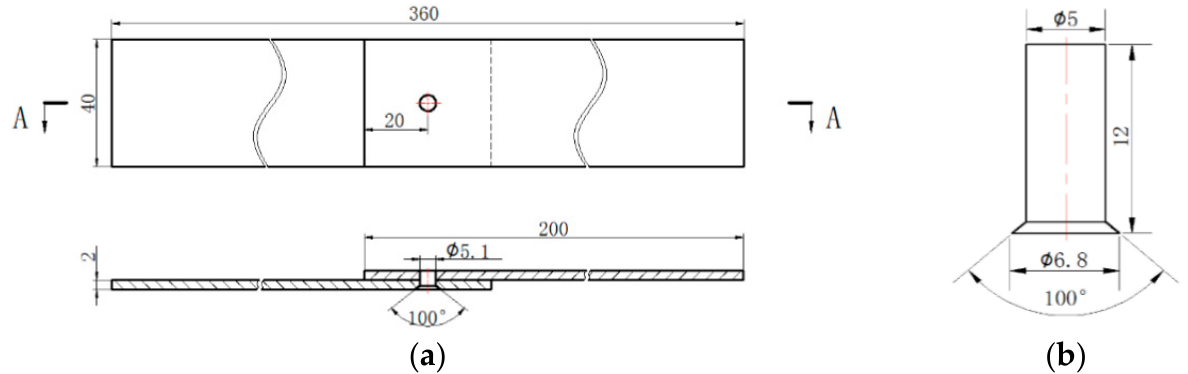
Figure 2. Schematic diagram of riveted lap joint structure and size: ( a ) the structure and size of the joint plate; ( b ) the structure and size of the countersunk rivet.